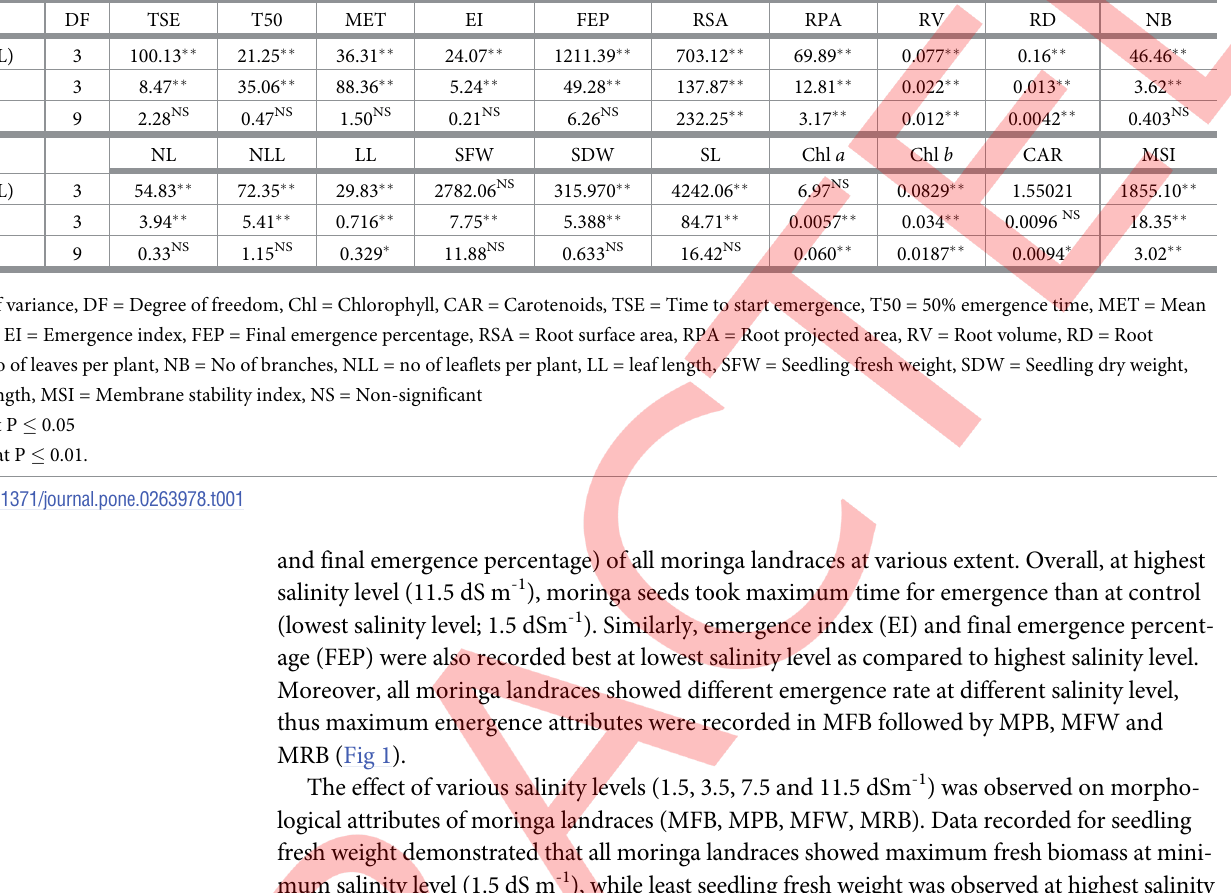
Table 1. Mean sum of squares of emergence, growth and physiological parameters of moringa landraces grown under varying salinity levels. SOV DF TSE Salinity levels